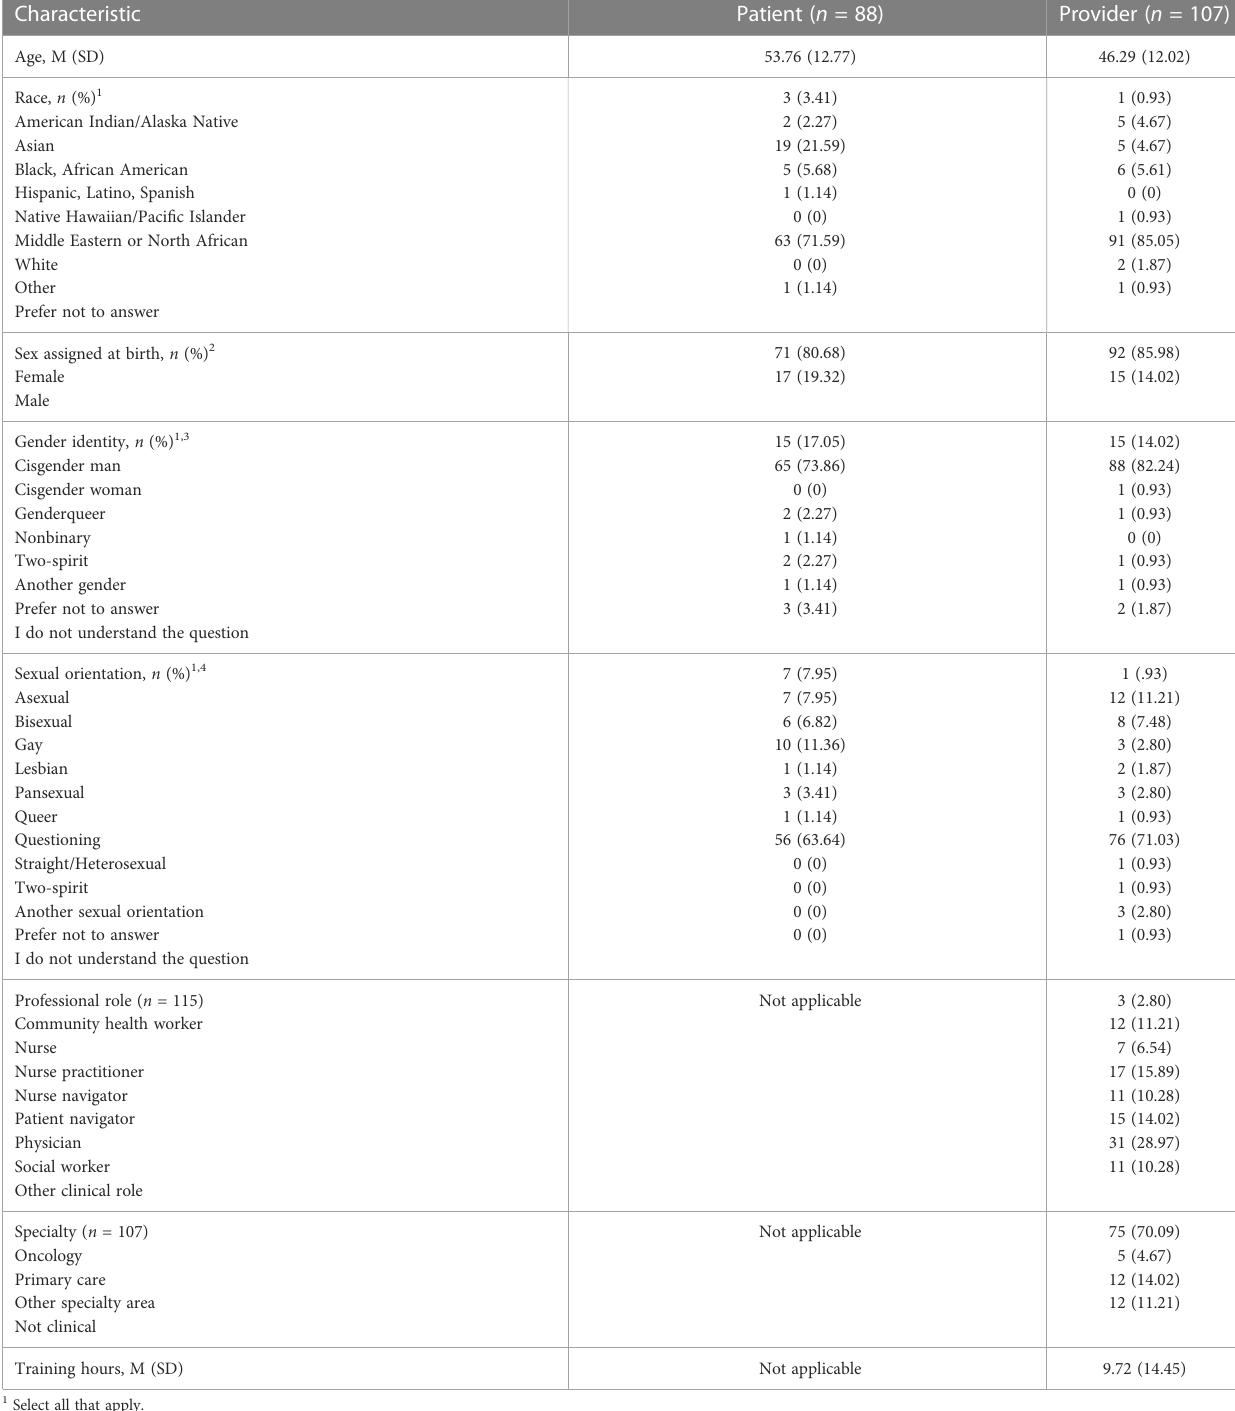
TABLE 2 Participant